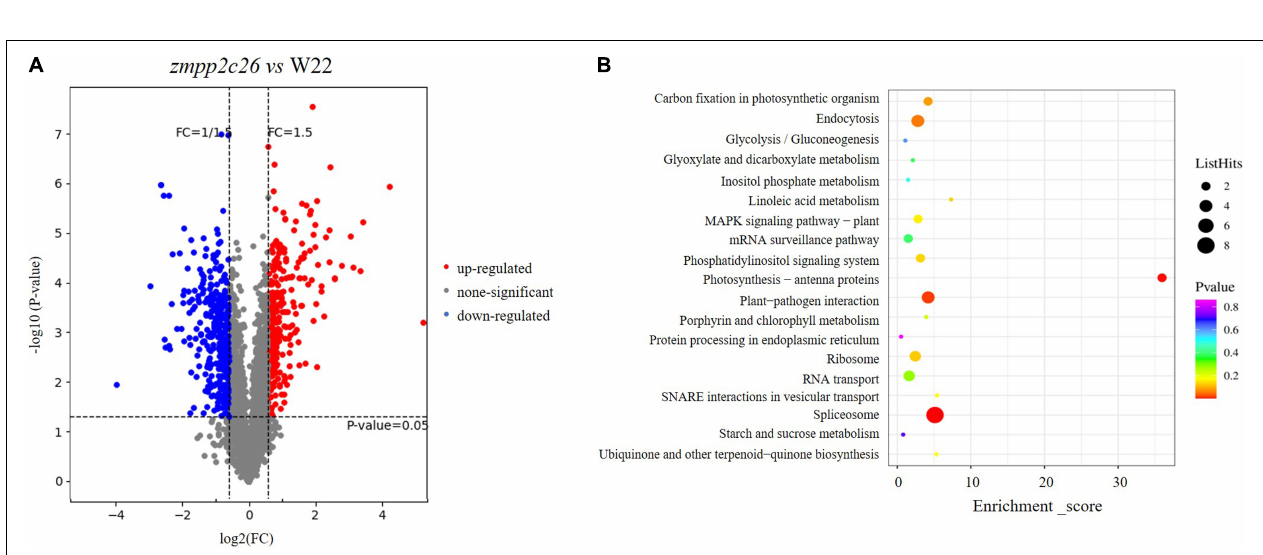
Frontiers in Plant Science |